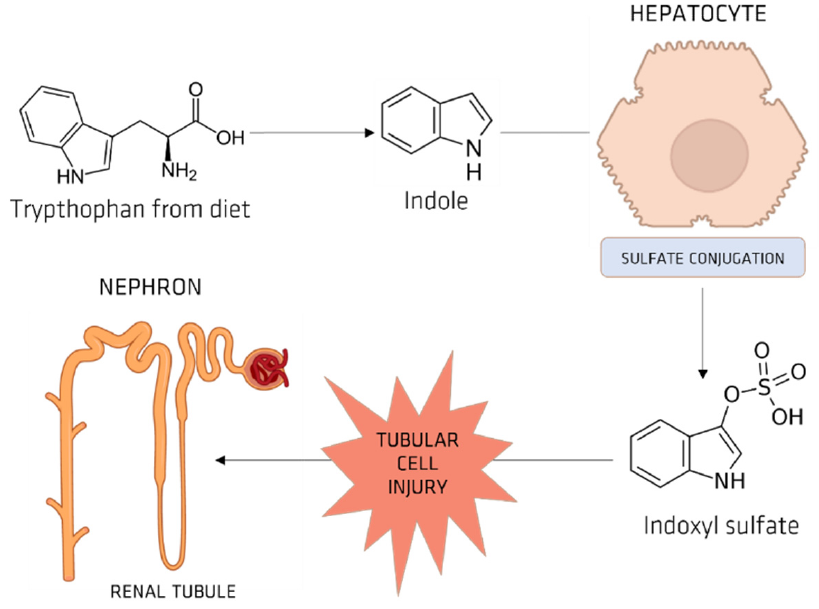
Figure 7. IS promotes the progression of CKD.